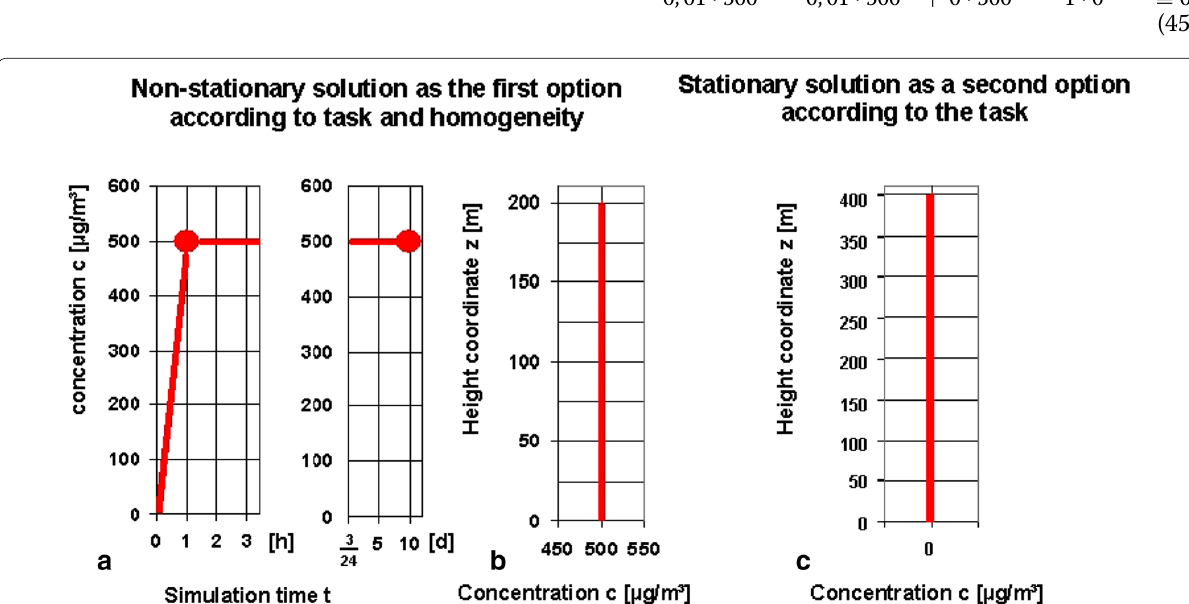
Fig. 3 The task of the AUSTAL authors trivially describes the filling of